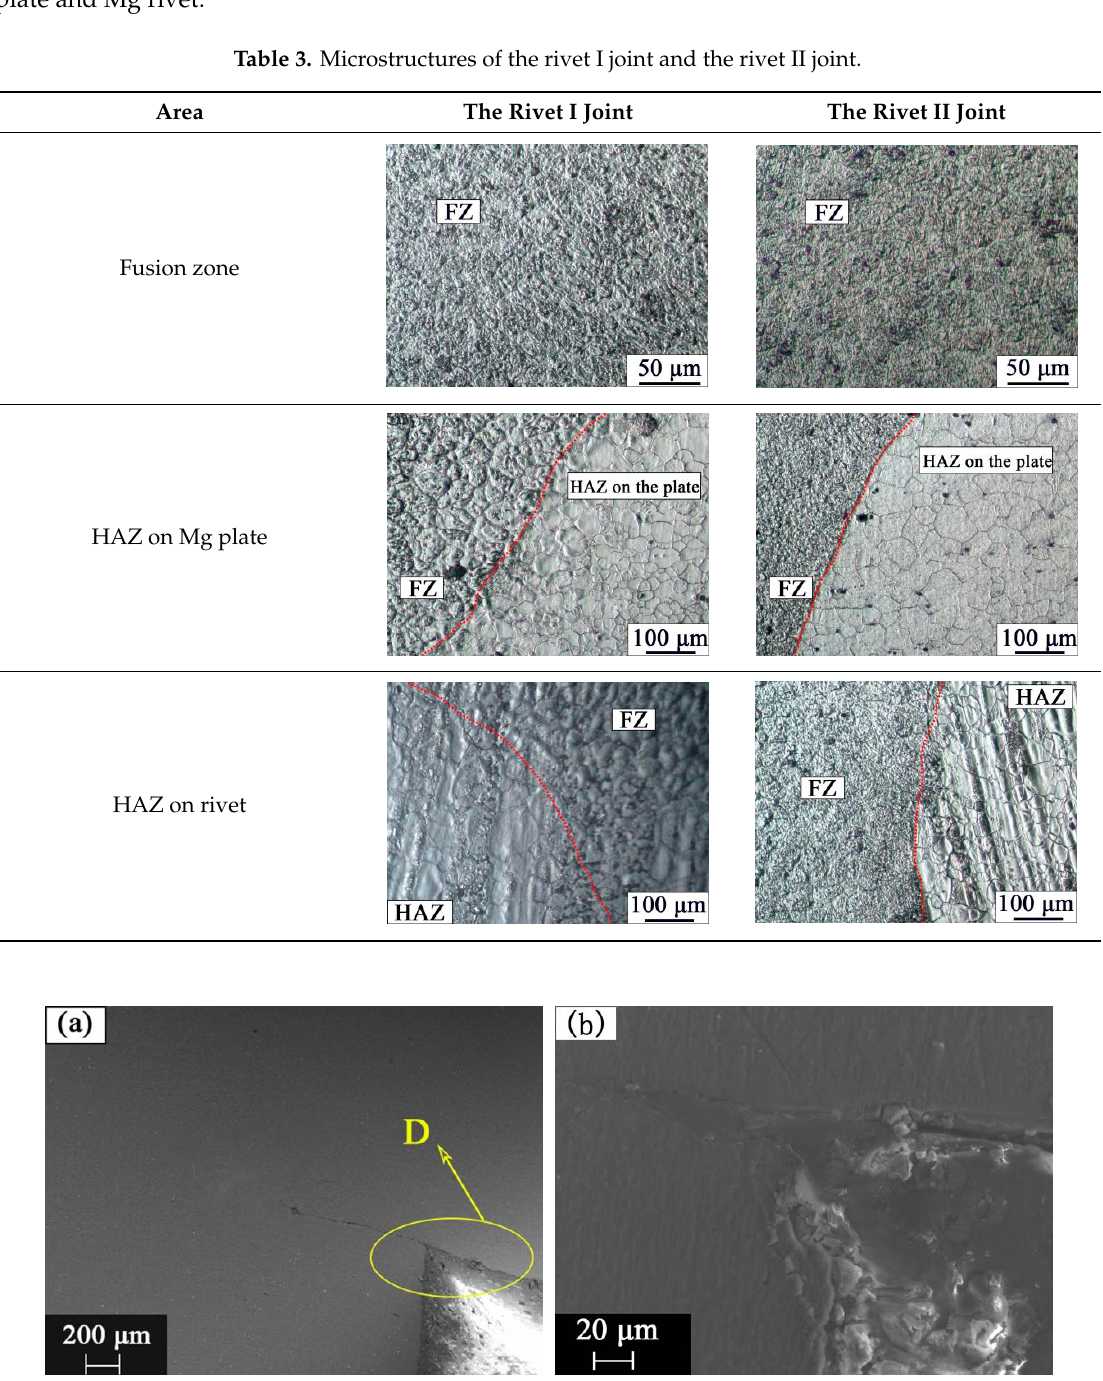
Figure 8. The SEM images of ( a ) A region in Figure 5a and ( b ) D region.